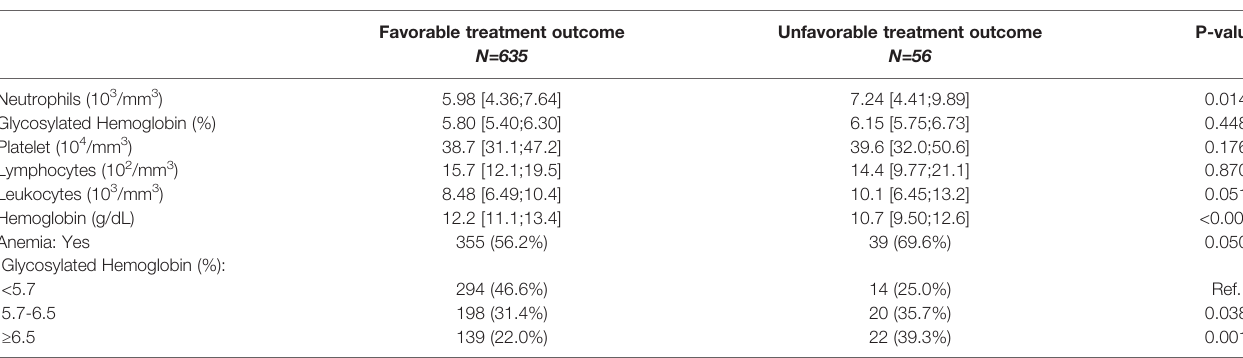
TABLE 4 | Laboratory values, strati fi ed by TB treatment